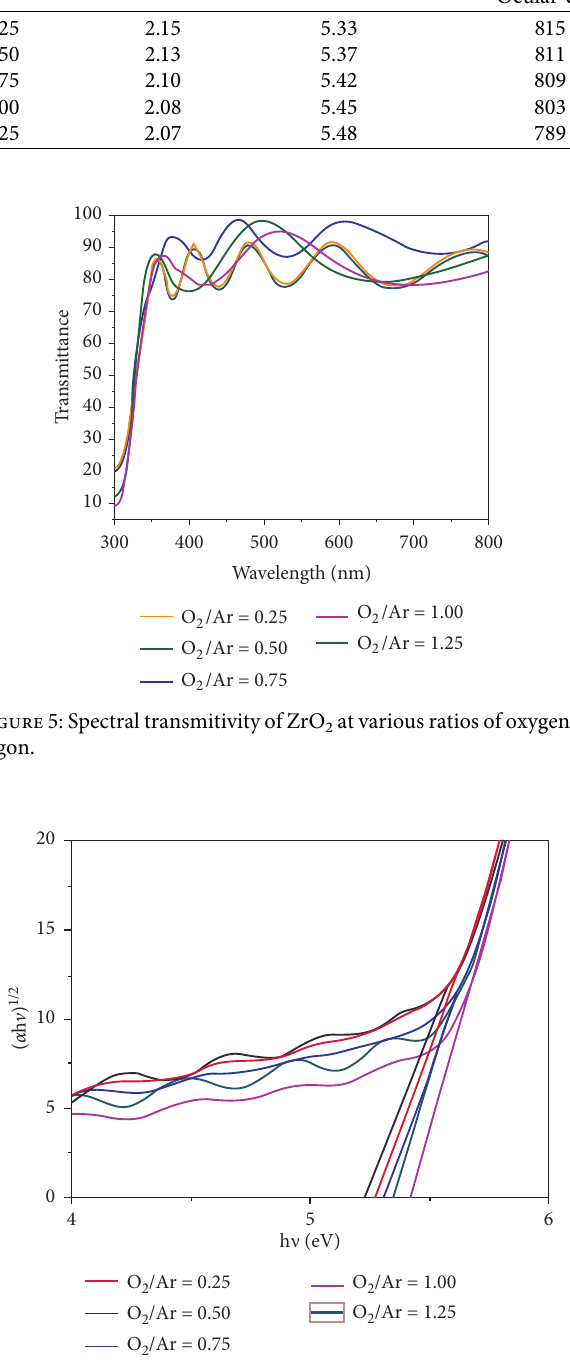
Figure 6: Band gap of ZrO 2 at various ratios of oxygen/argon.